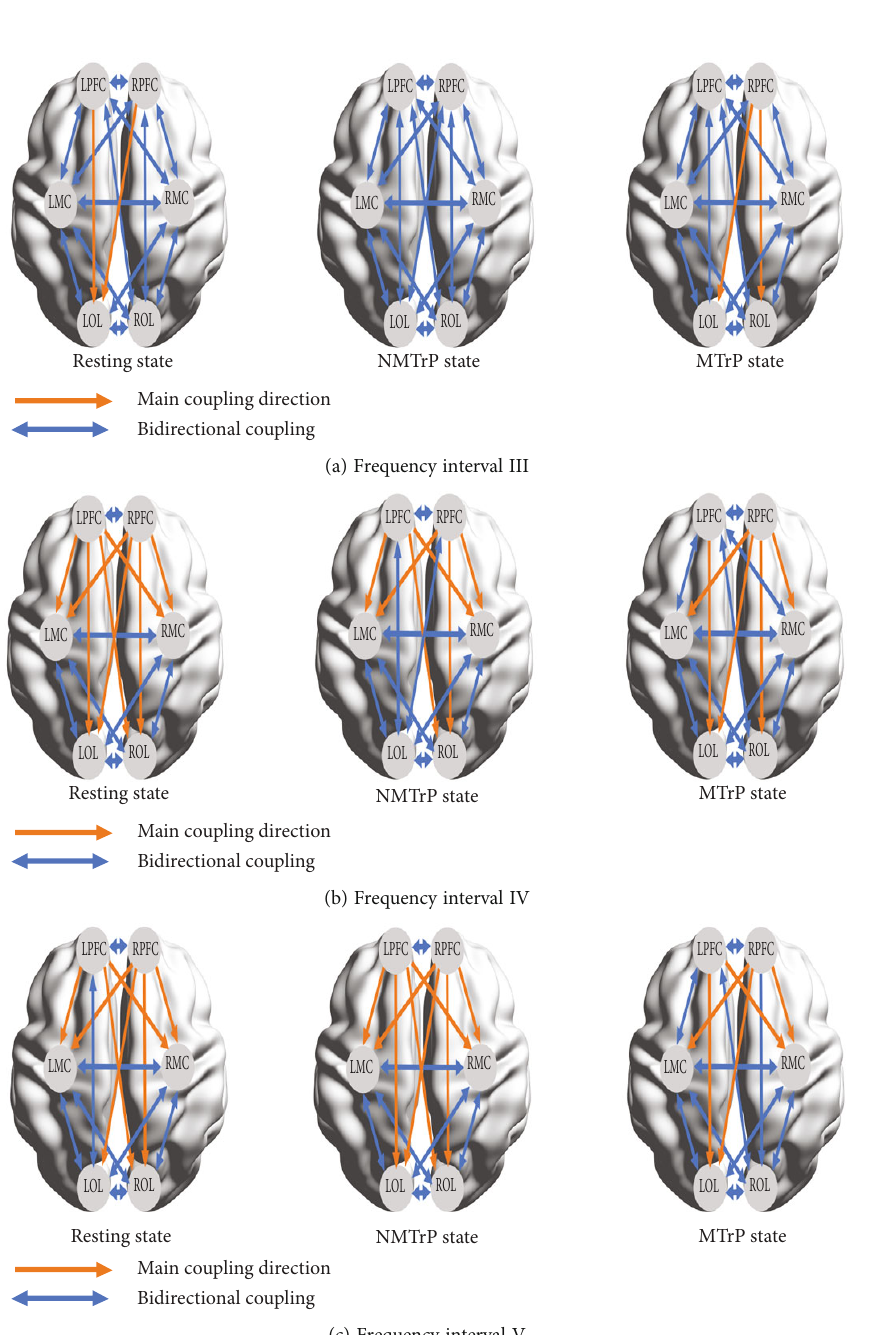
Figure 7: Illustration of frequency-speci fi c interregional main coupling directions (mCD) (resting state, NMTrP state, and MTrP state) among the six brain regions in frequency intervals III (a), IV (b), and V (c), respectively. MTrP: myofascial trigger point; NMTrP: nonmyofascial trigger point; L: left; R: right; PFC: prefrontal cortex; MC: motor cortex; OL: occipital